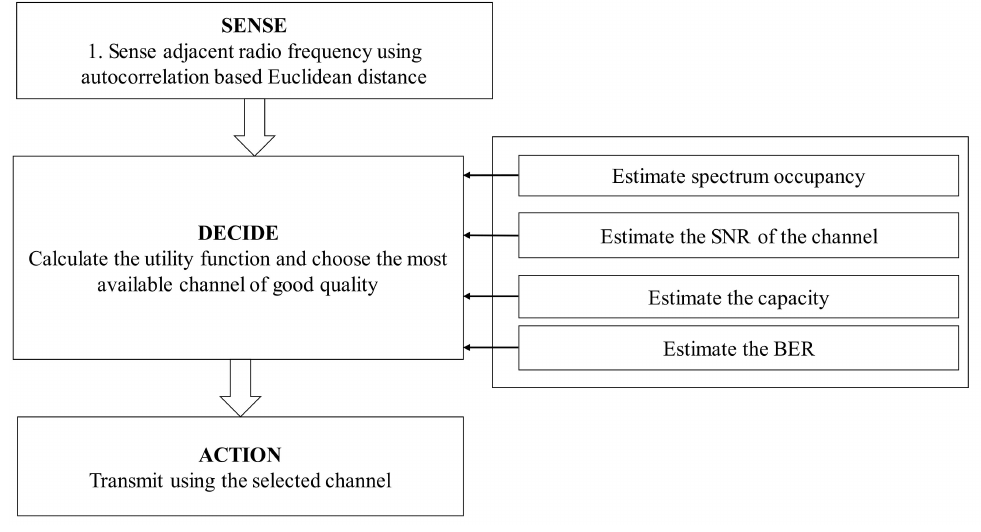
Figure 1. Processes of selecting the best